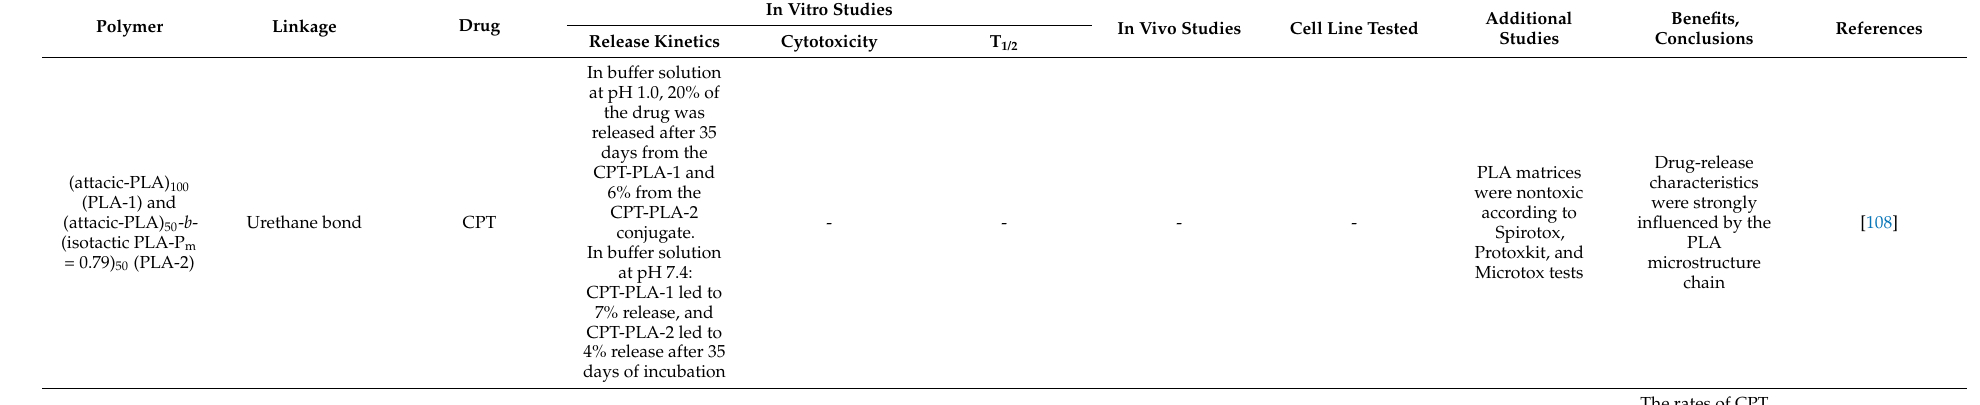
Table 3. Biodegradable polyester DDSs of CPT and its analogues obtained by covalent drug